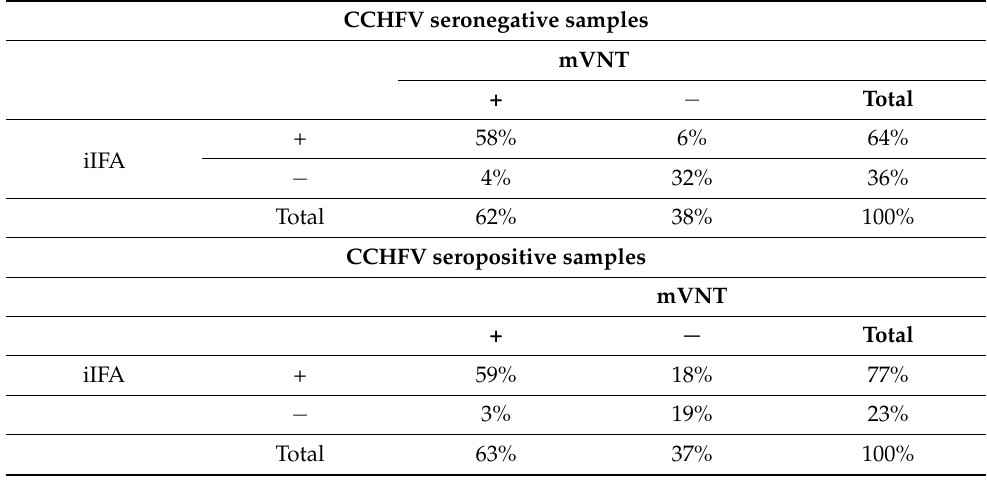
Table 5. Comparison of DUGV iIFA and DUGV mVNT.